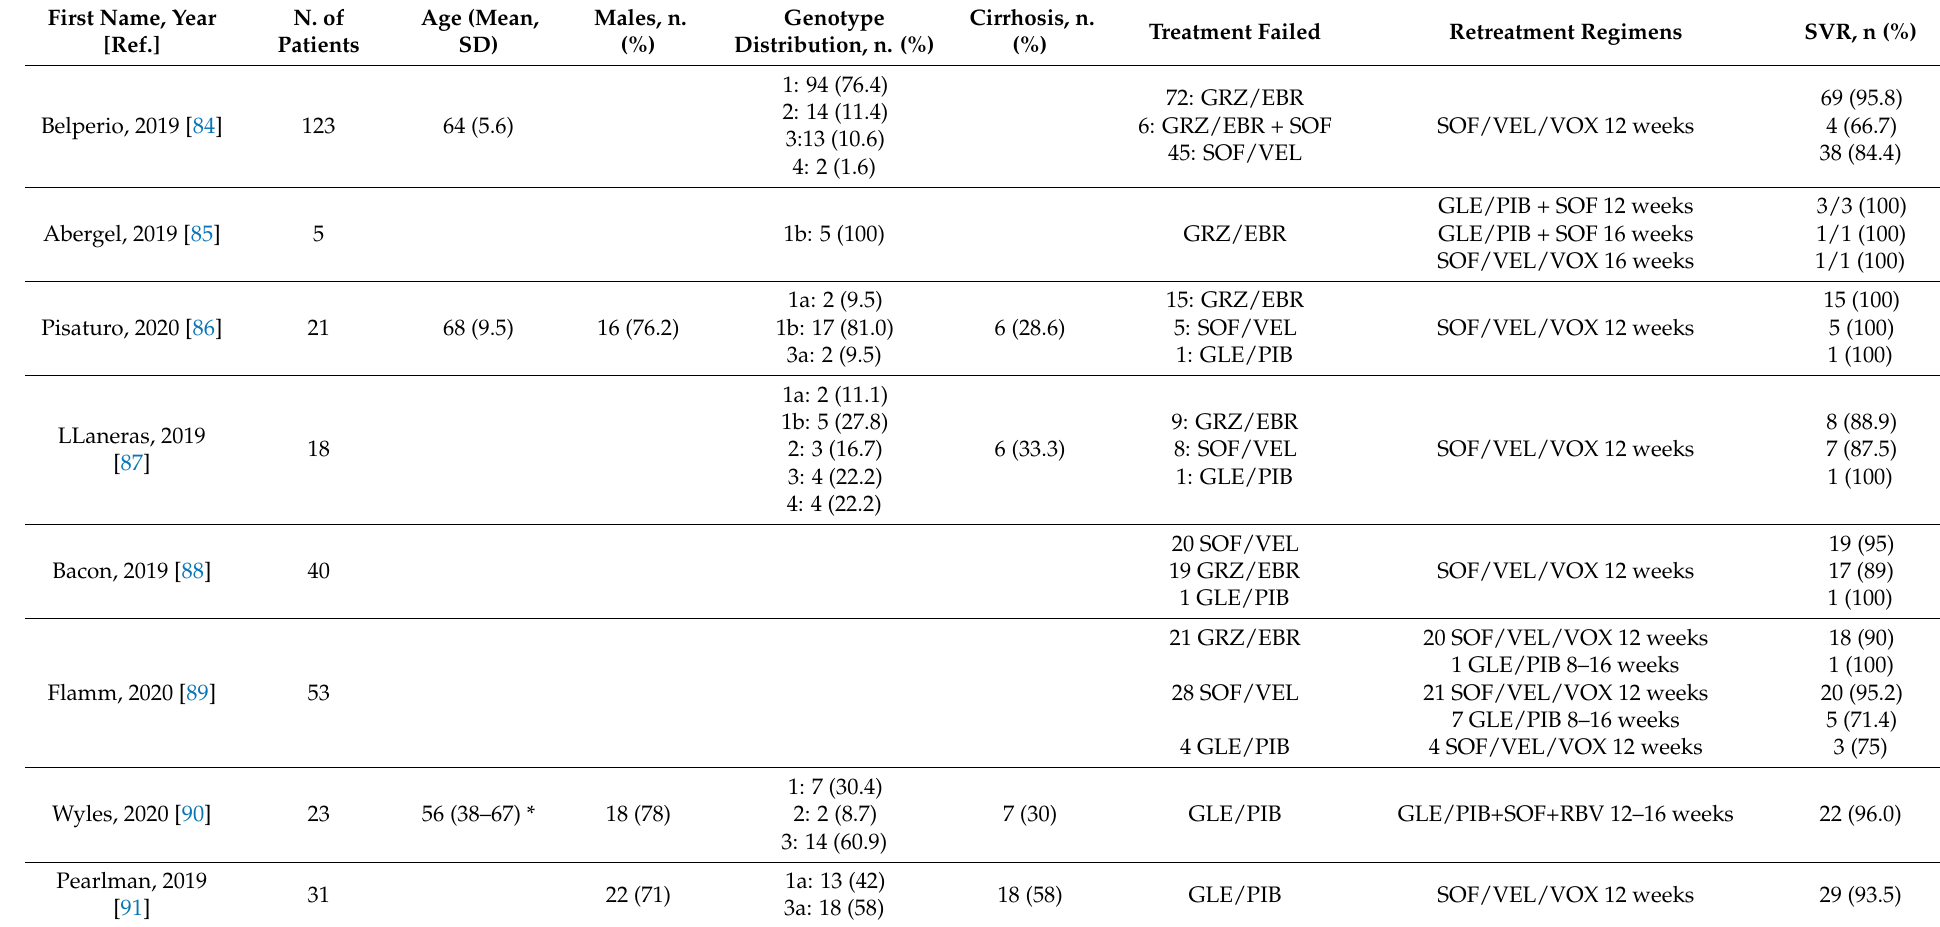
Table 5. Studies evaluating retreatment options after failure to the latest-generation